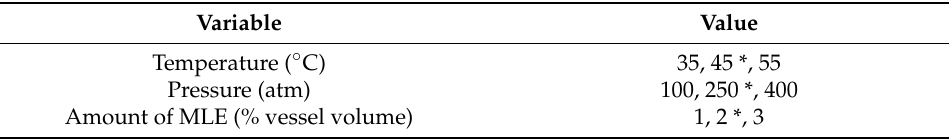
Table 2. Analyzed variables for the impregnation